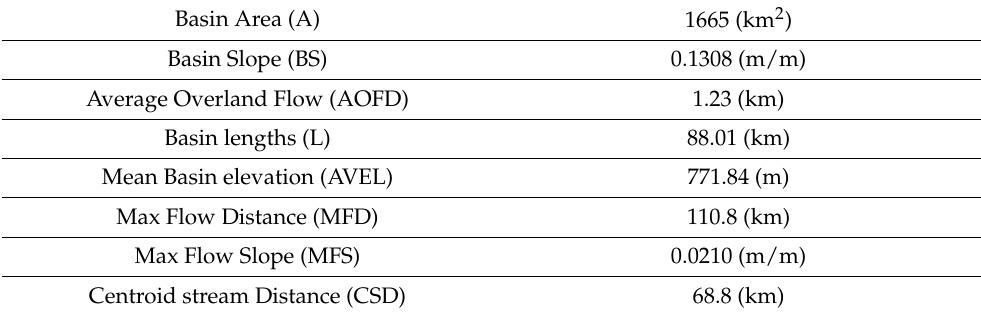
Table 1. Topographic parameters of Wadi Yalamlam catchment.